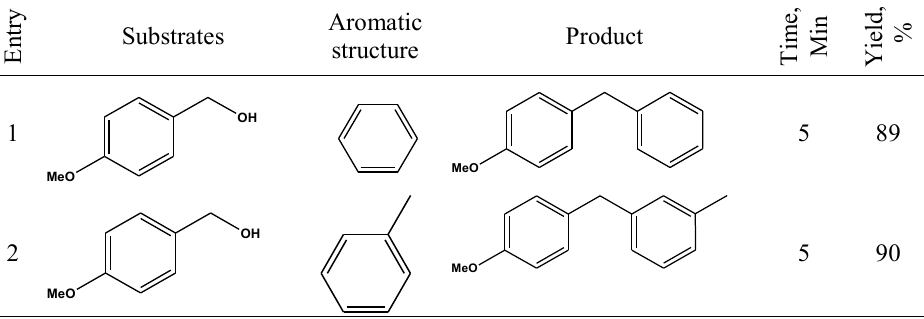
Table 1. The results related to Friedel-Crafts reaction of alcoholic and aromatic structure in the presence of supported acid on silica